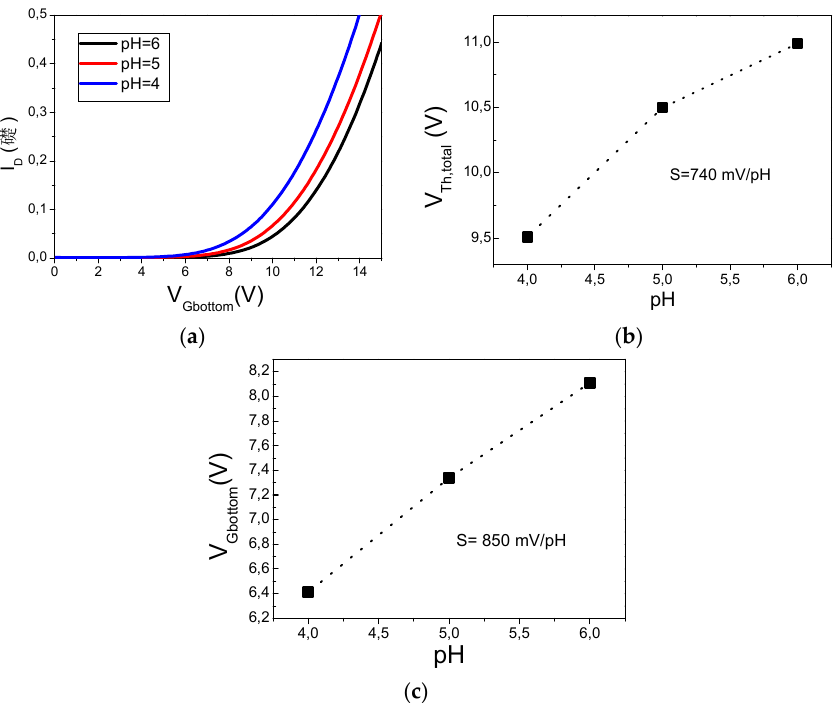
Figure 3. ( a ) Transfer characteristics with different pH values; ( b , c ) calibration curve and sensitivities